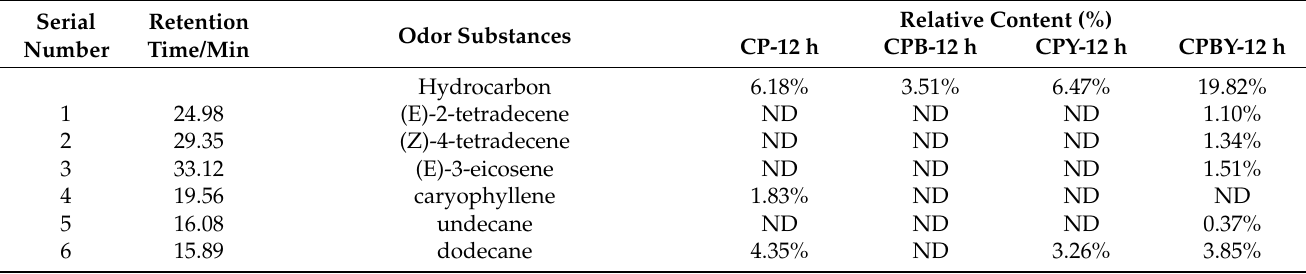
Table 4. Volatile odor substances in four groups of fermented